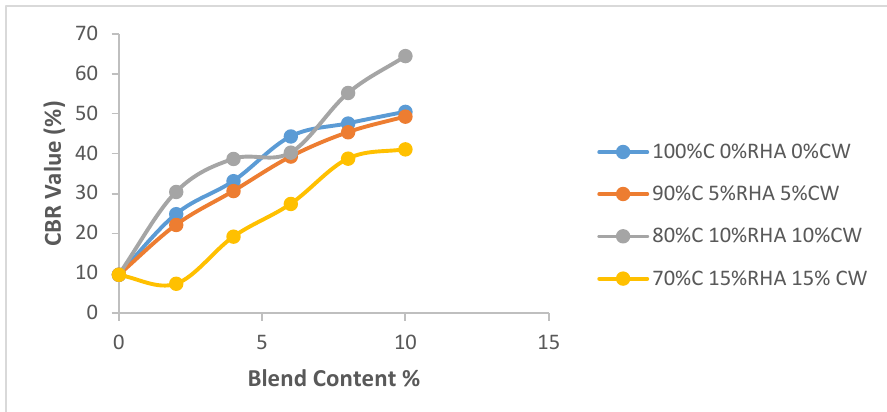
Fig. 8. Relationship between the CBR values immediately after compaction of (100%C 0%RHA